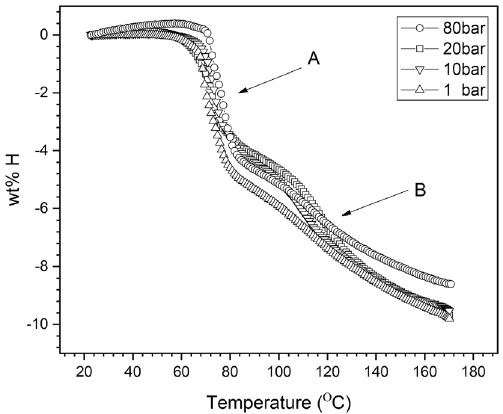
Fig. 2 Dynamic thermal decomposition of LiNH hydrogen pressures (heating rate 1 °C min −1 in Sievert apparatus). The A and B steps of dehydrogenation are emphasized